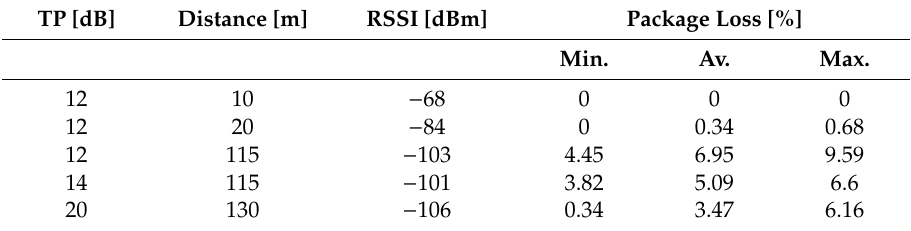
Table 1. Node communication performance. Received Signal Strength Indicator (RSSI) and package loss values according to nodes transmission power and distance between node and indoor gateway. TP